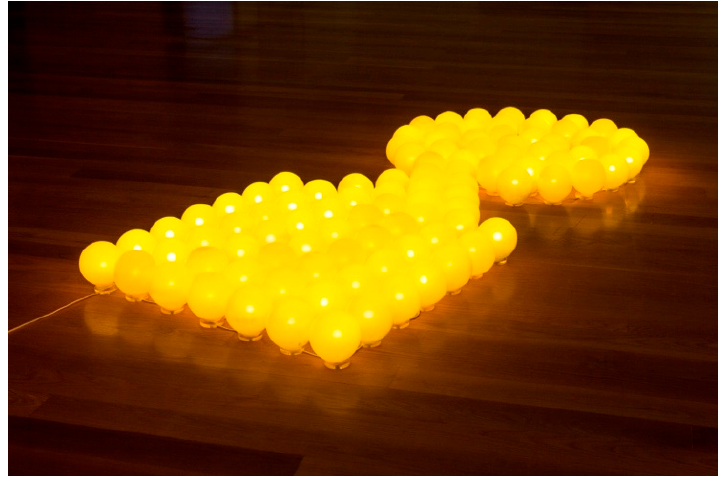
Figure 9. Joana Vasconcelos, “Pop Luz”, 1995. © Bruno Lopes/Coleção Arte Fundação EDP/Col. Cabrita Reis.